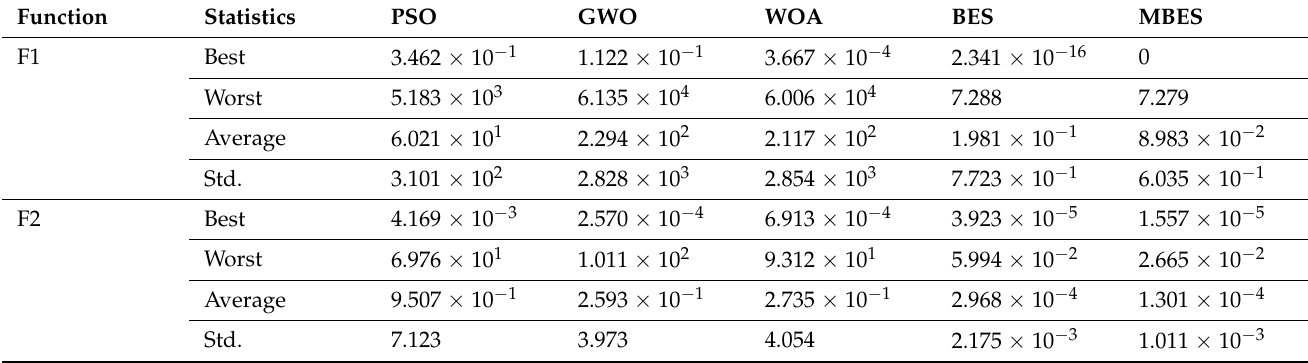
Table 3. Results for unimodal benchmark